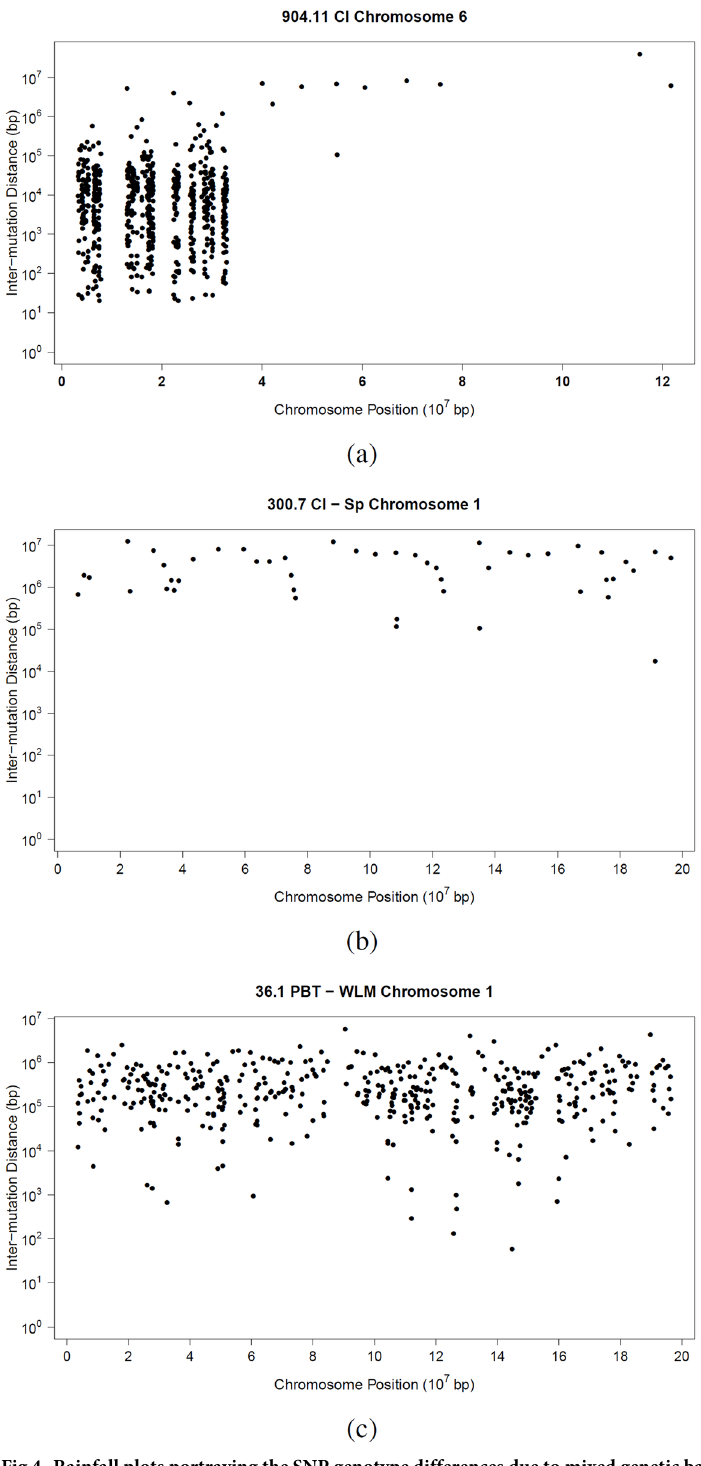
Fig 4. Rainfall plots portraying the SNP genotype differences due to mixed genetic background, putative new mutations arising during development of two normal tissues of the same mouse and putative mutations arising between two cancerous tissues from the same mouse. (A) Rainfall plot for chromosome 6 from a mouse (identifier: 904.11) with mixed genetic background (75% C57BL/6J and 25% CBA/CaJ). (B) Rainfall plot for chromosome 1 for a comparison of normal cerebellum and spleen tissue from the same mouse (identifier: 300.7). (C) Rainfall plot for